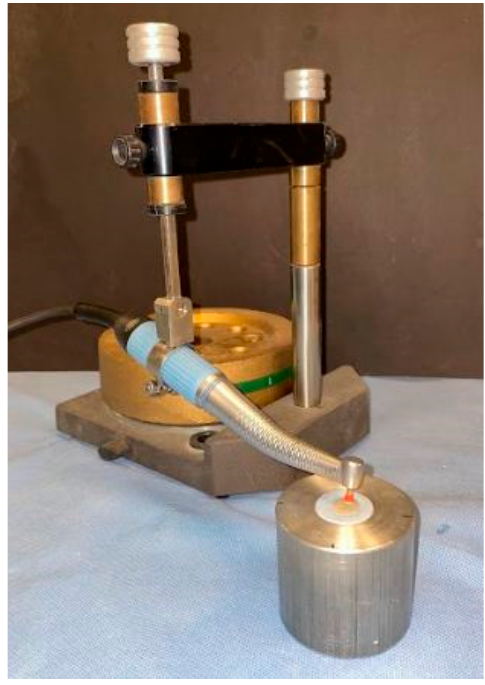
Figure 2. Customized holder for polishing the specimen .